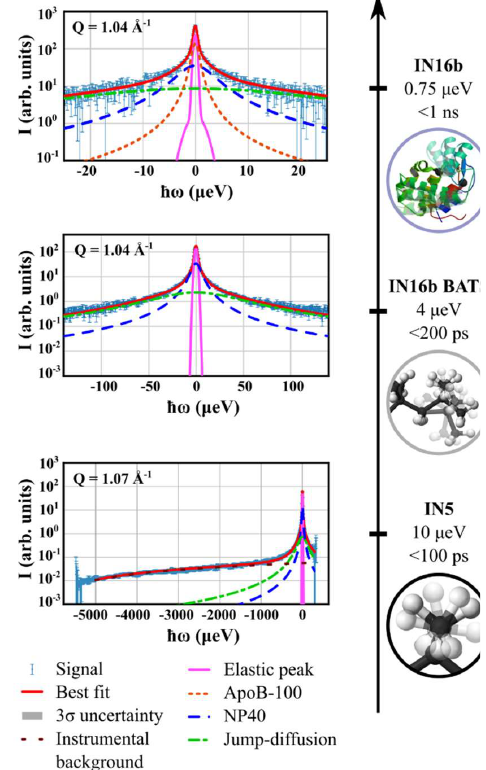
Fig. 18. An example of apo B-100/NP40 data fitting (modified from [107]) on 3 spectrometers (IN16b - top; IN16b BATS - middle; IN5 - bottom) at Q = 1.05 Å −1